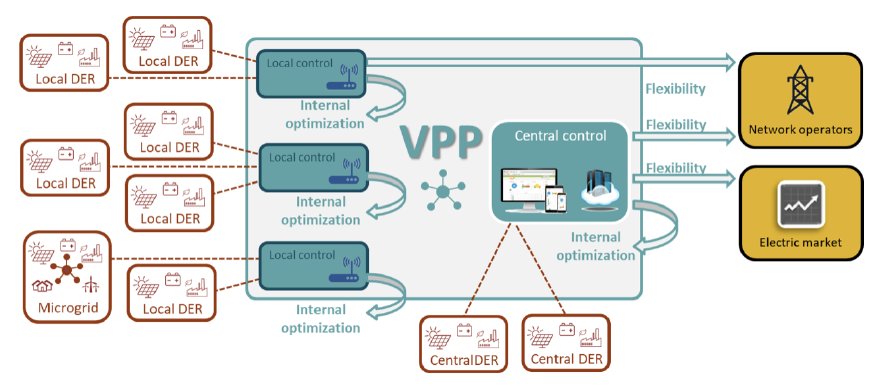
Figure 2. A VPP distributed